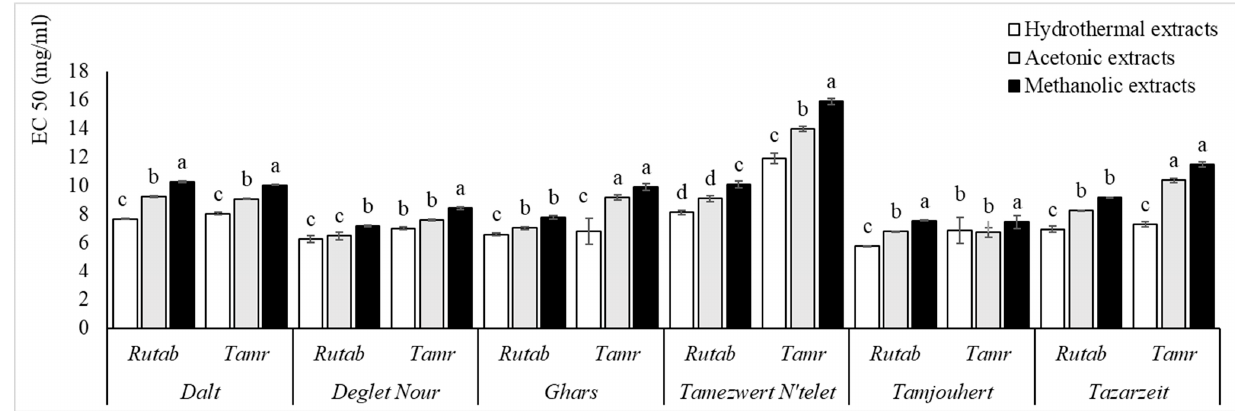
Figure 2. The 1,1-Diphenyl-2-picrylhydrazyl (DPPH) scavenging capacity of all cultivars and ripe stages for the three extraction systems. Values are mean ± SD. Different letters indicate that the results are statistically different ( p < 0.05, b < a ). Foods 2021 , 10 , 503